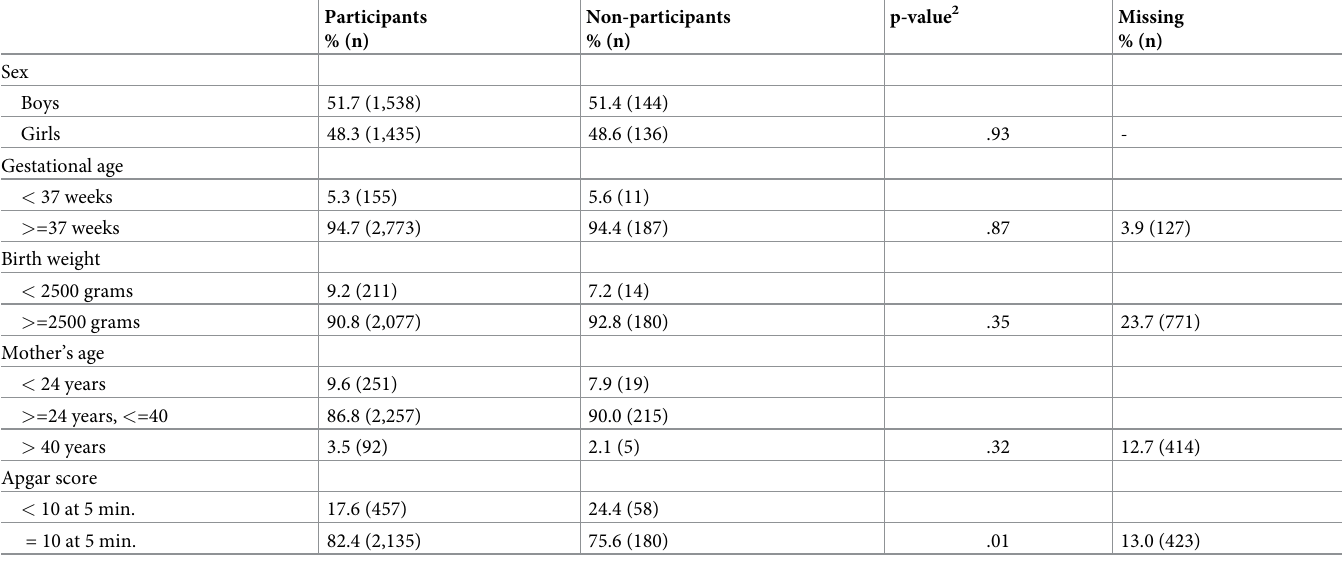
Table 2. Characteristics of the study population (N = 3,253 1